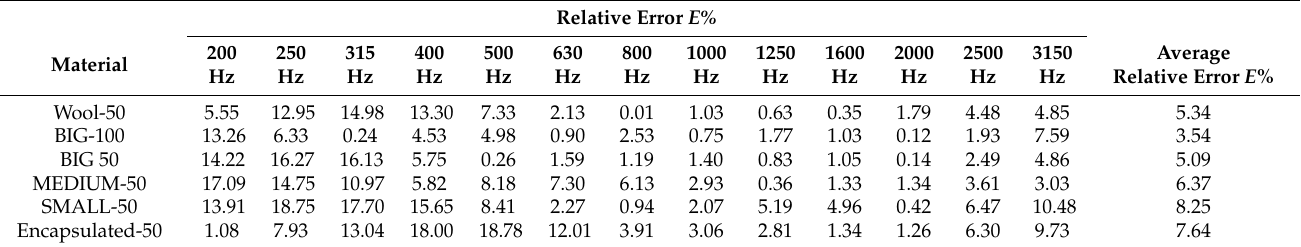
Table 3. Relative errors for third octave bands and average values of the relative errors.